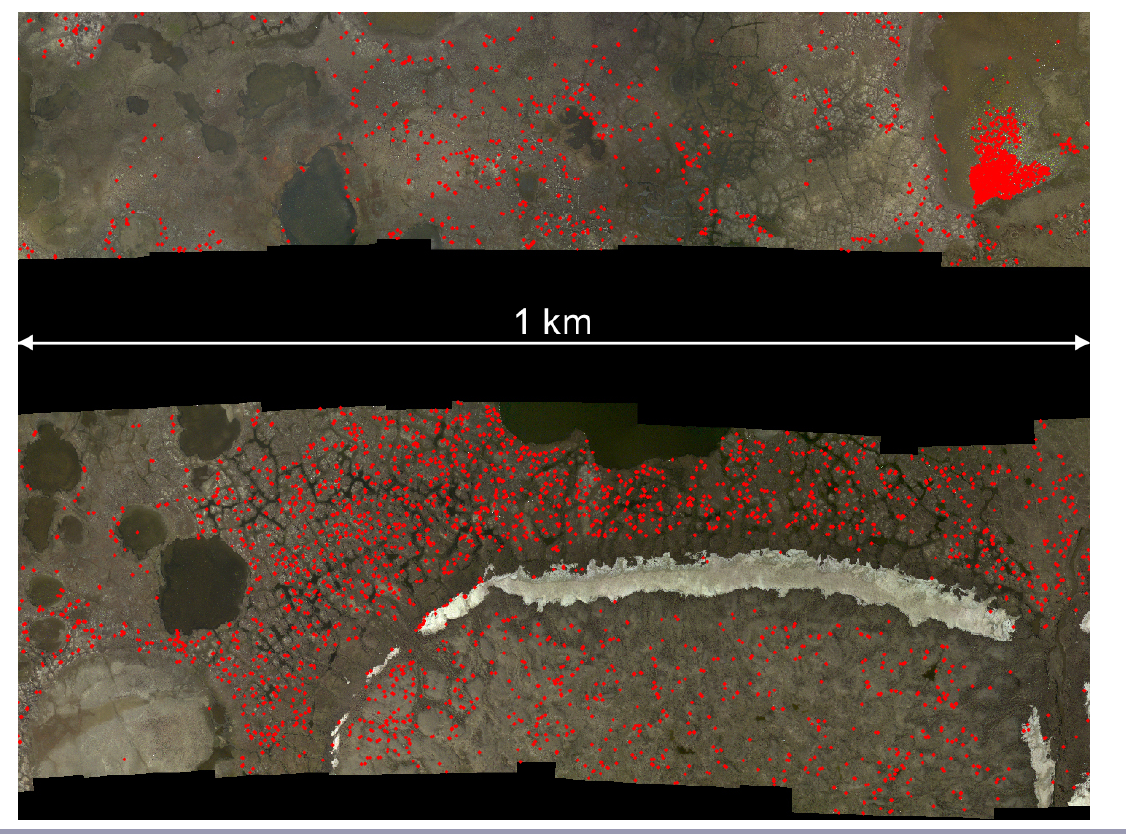
Fig. 10 . Coarse-scale overview of a mosaic of aerial images captured along two parallel flight lines over the Banks Island-Egg River Lesser Snow Goose ( Chen caerulescens caerulescens ) breeding colony in 2009, with the automated classification layer overlaid, showing all features classified as geese in red. A dense cluster of commission errors caused by speckles of glint on the surface of water is evident near the top right-hand corner, as well as errors caused by small patches of snow around the periphery of the large patches in the bottom part of the image. Deleting these errors from the classification layer took 2 min, compared to 107 min to manually count all geese in the